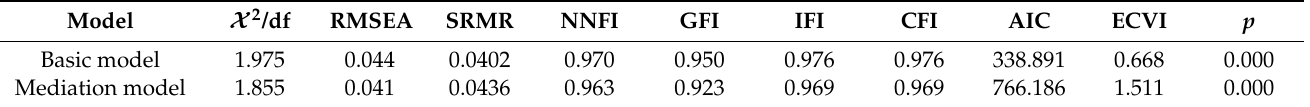
Table 5. Fitting indices for default model.